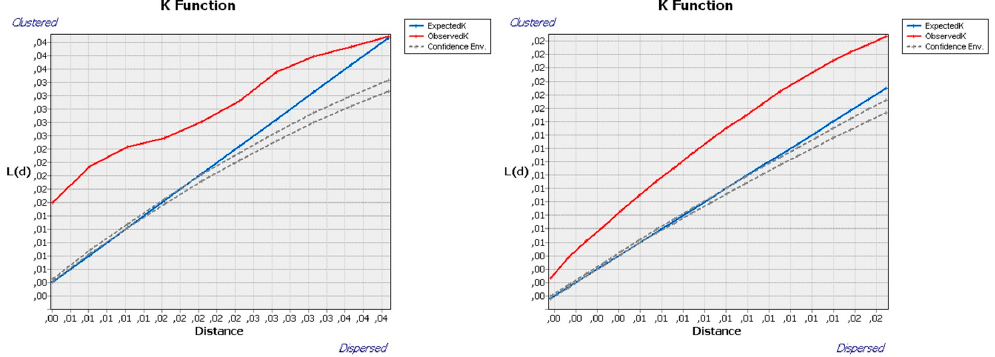
Figure 6. Measure of spatial clustering for a range of distances in Tarragona ( left ) and Terrassa ( right ). Source: own elaboration.